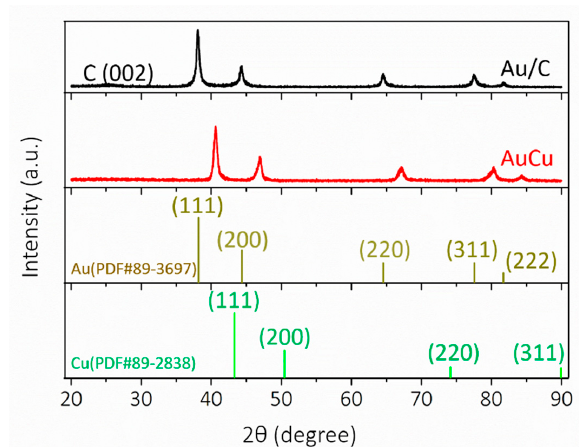
Figure 3. ( a ) HRTEM image of the kink in AuCu, and ( b ) relative enlarged HRTEM and FFT images of the red-white parts in ( a ).